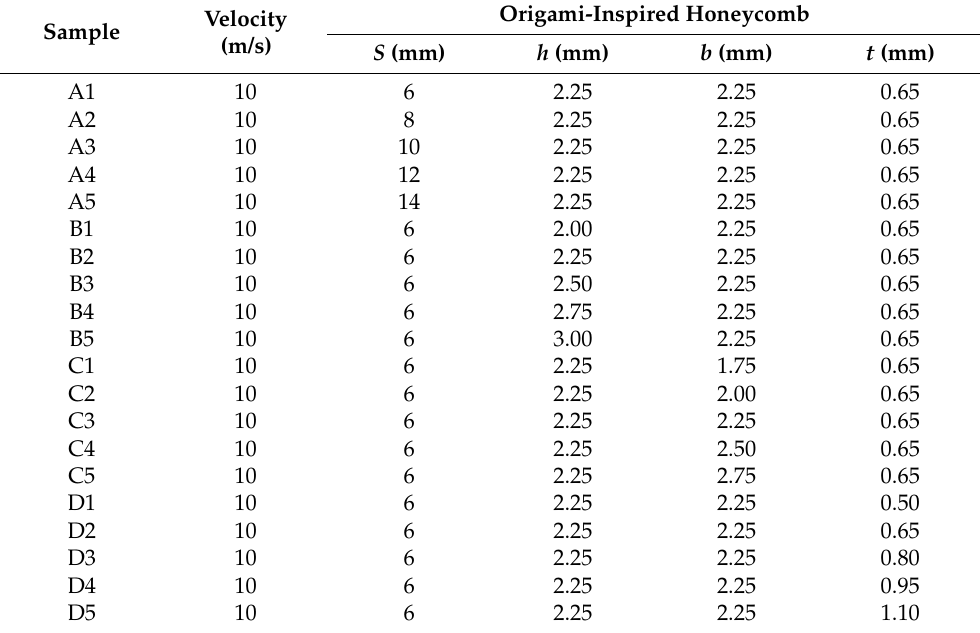
Table 1. Characteristics of the investigated concave I-shaped honeycomb